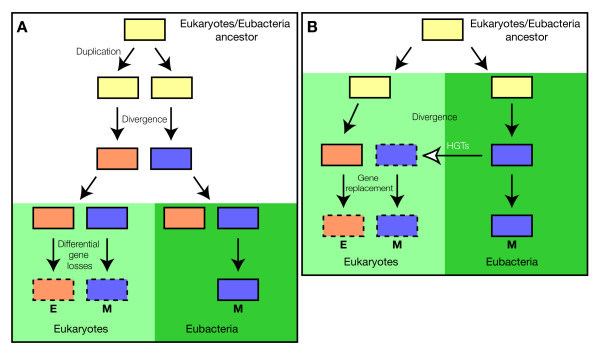
Evolutionary history of class 4 HDACs. Two possible evolutionary scenarios are represented. E, eukaryotic-group HDAC; M, mixed-group HDAC. Dotted lines indicate that the gene is not present in all eukaryotic species (see text for details).